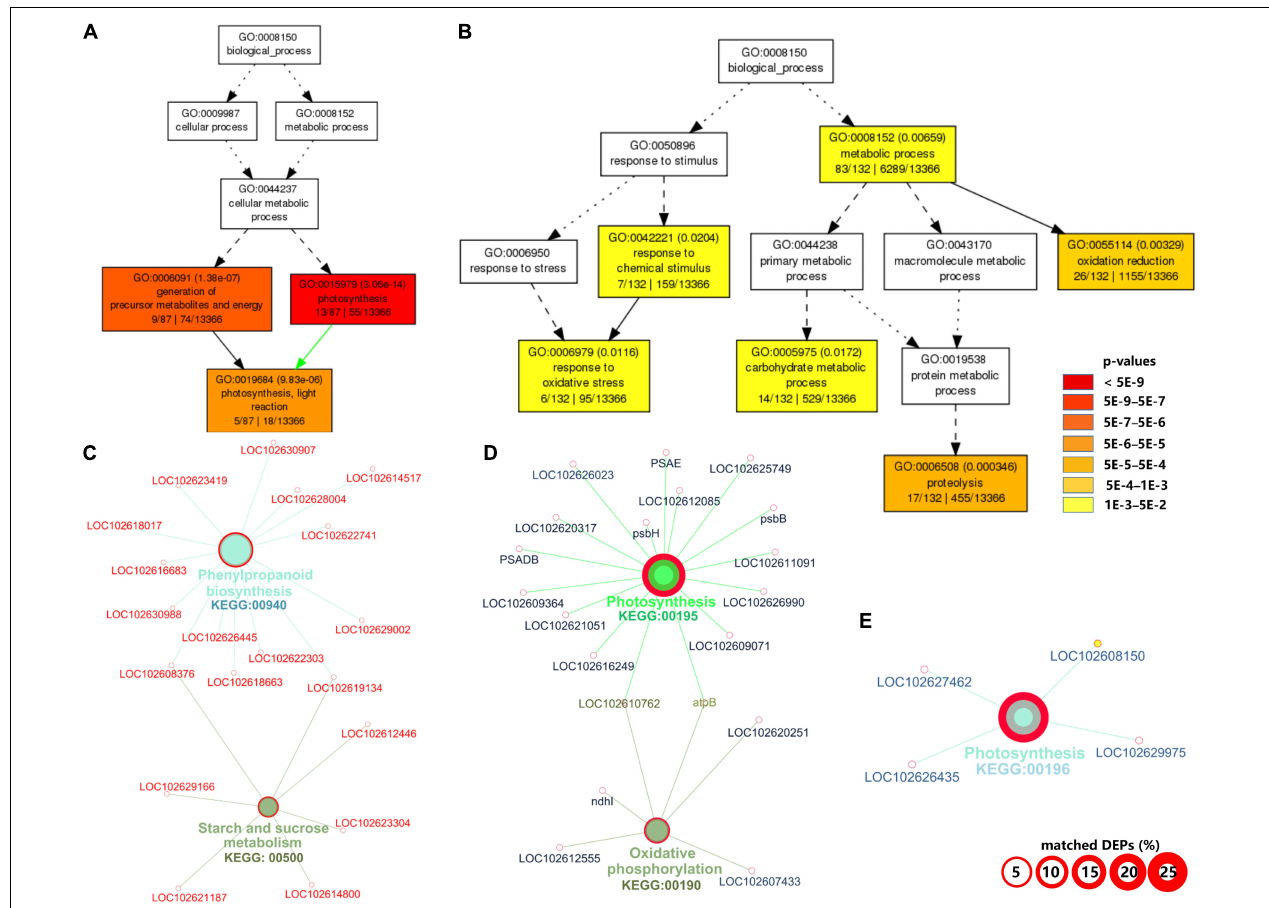
FIGURE 2 | Gene ontology (GO) and Kyoto Encyclopedia of Genes and Genomes (KEGG) pathway enrichment analyses of differentially accumulated proteins (DAPs) between CI1 and MI1. Significant GO terms under the category of “Biological Process” for downregulated (A) and upregulated (B) proteins. Statistical test method: hypergeometric, and multi-test adjustment method: Yekutieli (FDR under dependency). The significant (term p value < 0.01) KEGG pathways related to downregulated (C) and upregulated proteins (D,E) . The width of the red border represents the proportion of matched DAPs in the corresponding KEGG term